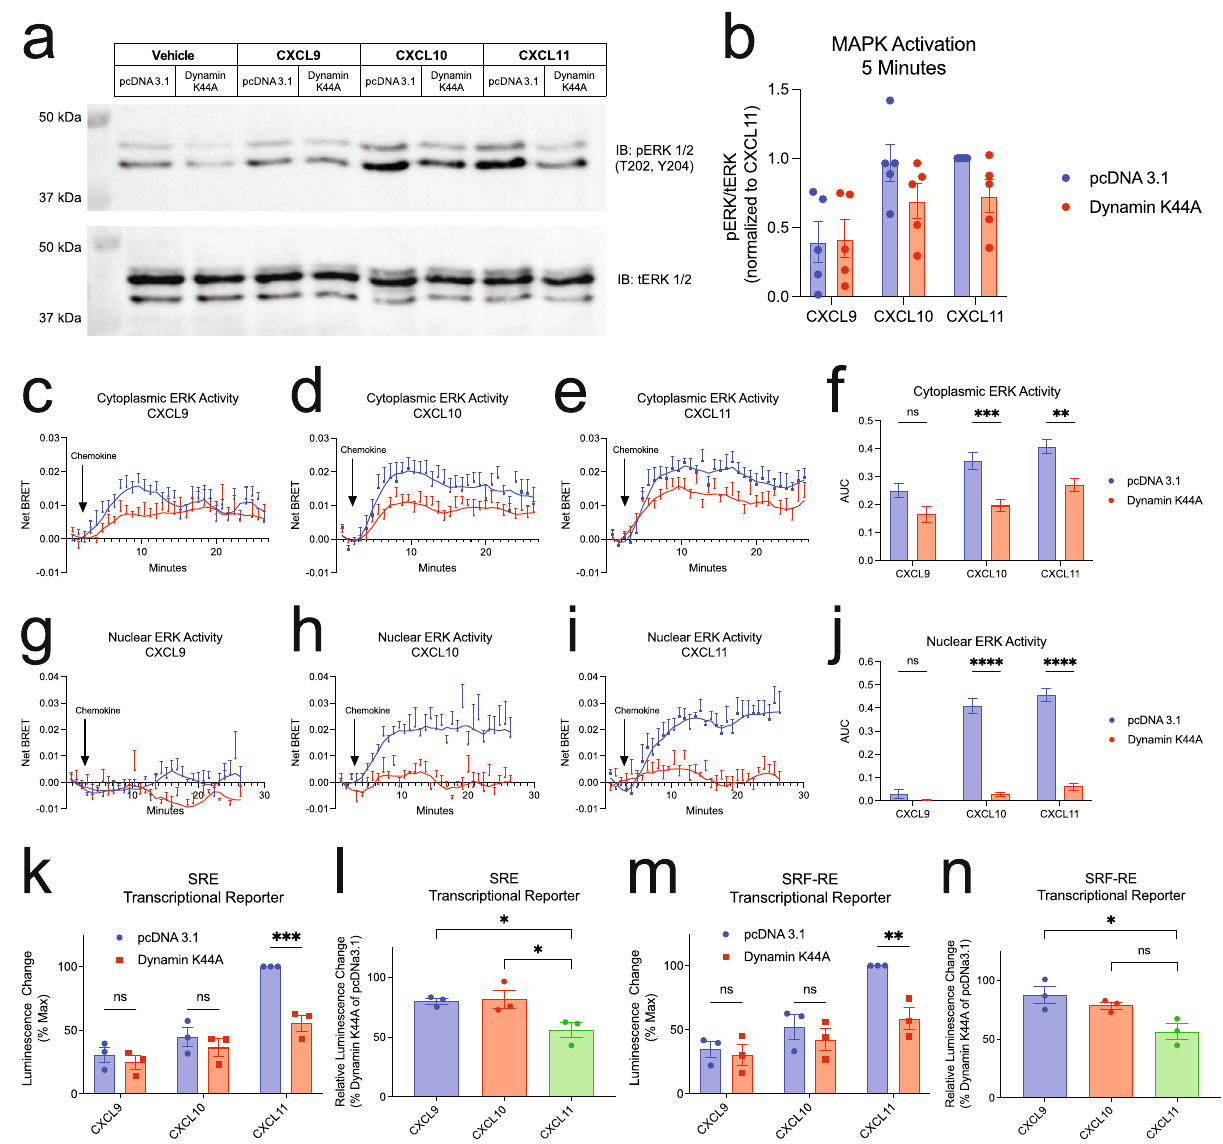
Fig. 5 | CXCR3 internalization is required for biased cytoplasmic and nuclear ERK1/2 activation and cellular transcription. a Representative western blot and b quanti fi cation of ERK1/2 phosphorylation following 5min of stimulation with vehicle control or 100nM chemokine with transfection of pcDNA 3.1 or Dynamin K44A. Data are the mean±SEM, n =5 independent experiments, and are normal- ized to CXCL11 and pcDNA 3.1. Kinetic data and quanti fi cation of AUC of